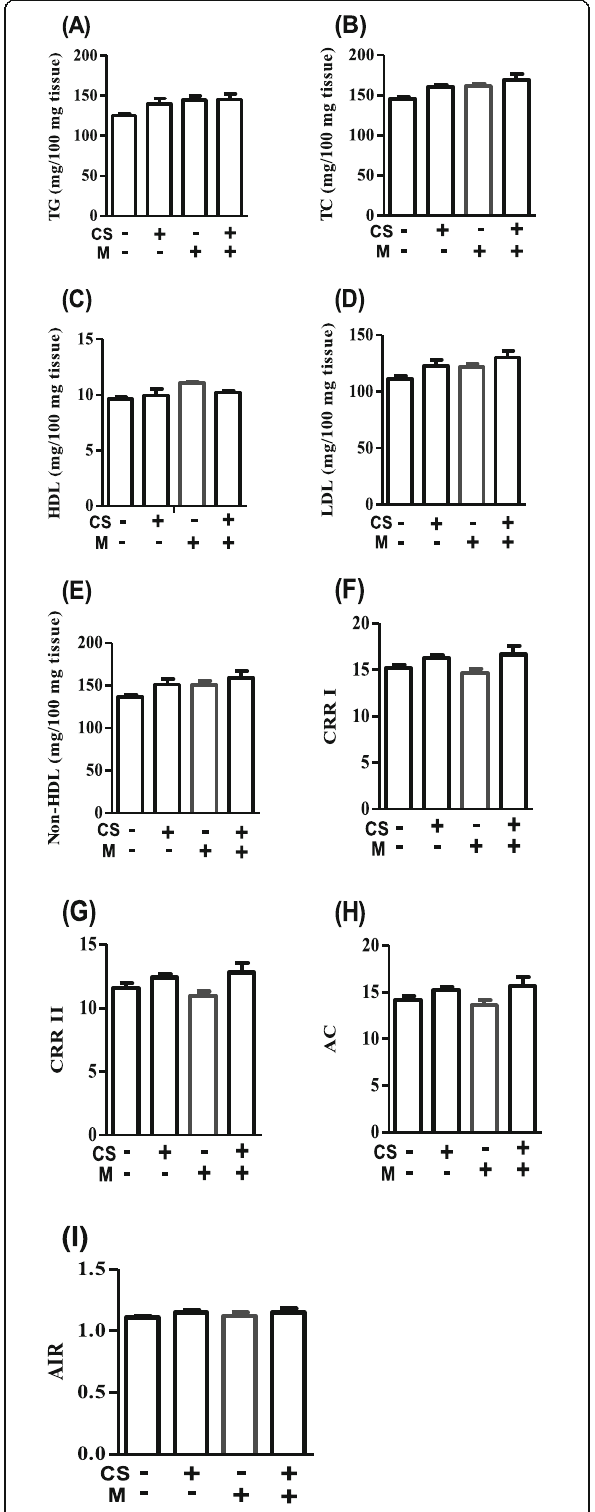
Fig. 1 CS and M do not alter brain lipid either when administered separately or when co-administered in female rats. A – I represent TG, triglyceride; TC, total cholesterol; HDL, high-density lipoprotein; LDL, low-density lipoprotein; non-HDL, non- high density lipoprotein; CRRI, cardiovascular risk ratio I; CRRII, cardiovascular risk ratio II; AC, atherogenic coefficient; and AIR, atherogenic index ratio respectively. CS, ethanol extract of Cannabis sativa ; M, melatonin; -, not administered; +,